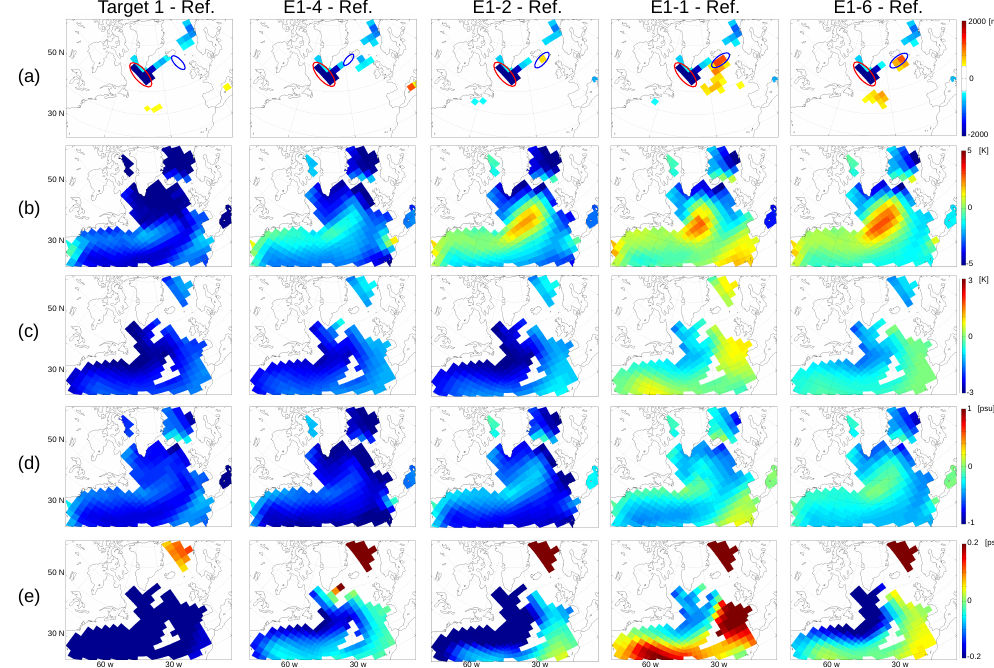
Fig. 4. Anomalies in Target 1, E1-4, E1-2, E1-1, and E1-6 compared to the reference state: the maximum monthly averaged mixed layer depth (a) , the temperature at the depth of 1000m (b) and 3000m (c) , and the salinity at the depth of 1000m (d) and 3000m (e) . In (a) , the deepest convection site is shown as a red ellipse for the reference state and as a blue ellipse for Target 1 and each experiment.